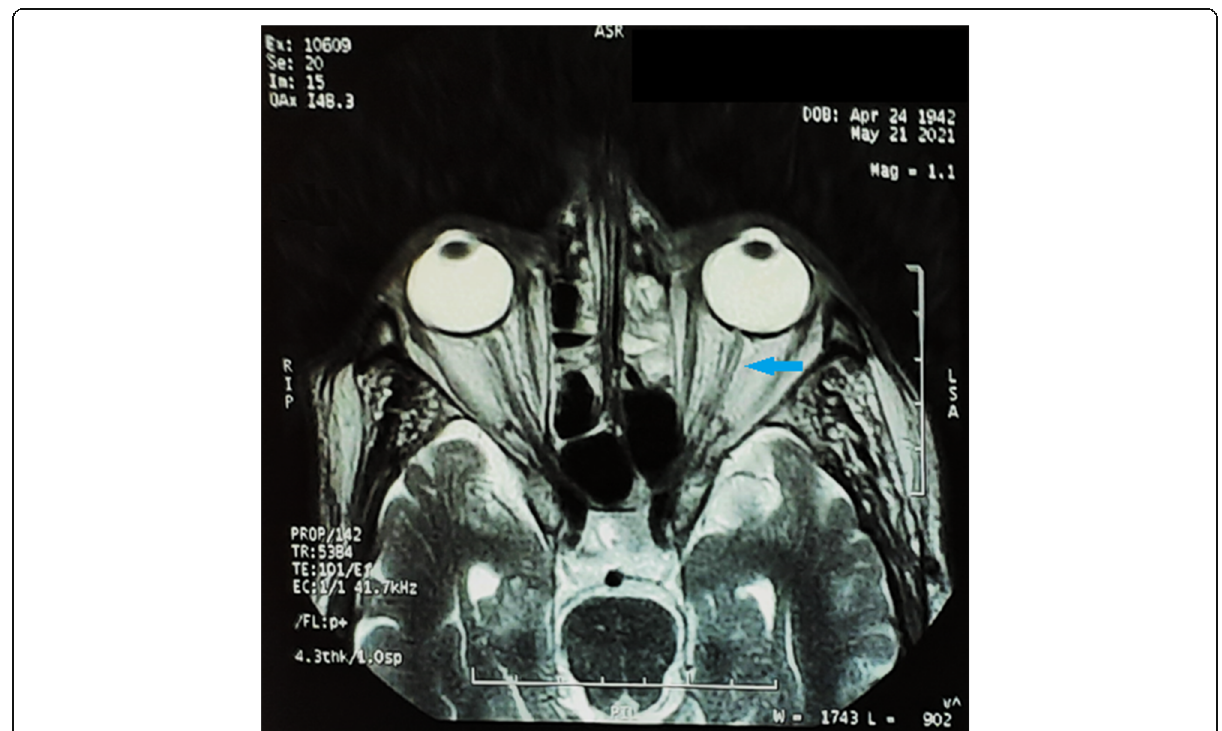
Fig. 3 Blue arrow along non contrast MRI T2 WIs highlighting mild form of left optic